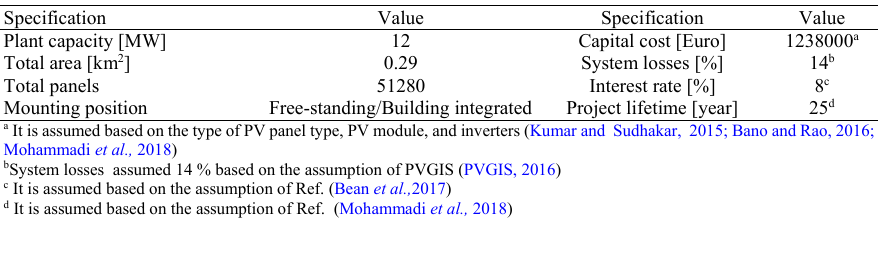
Table 10: Economic performance and electricity production by 12 MW PV system at the selected regions Mounting position Free-Standing